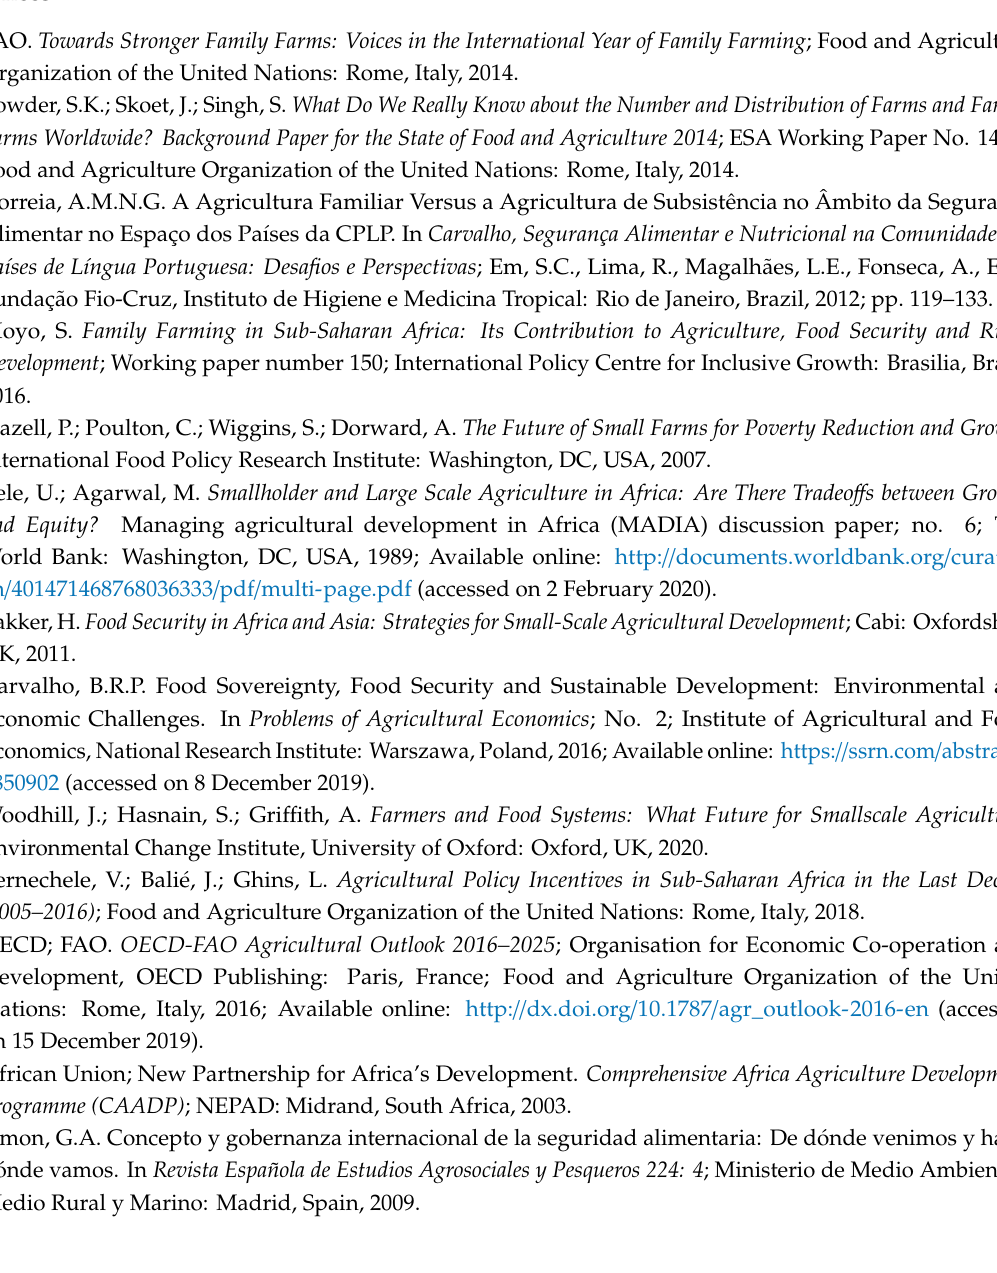
Figure A2. Arrows colours and width.